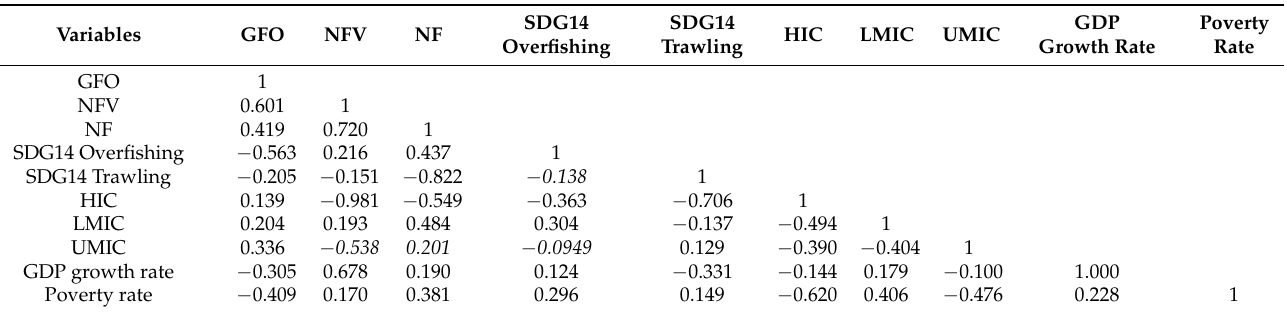
Table 3. Pearson correlation